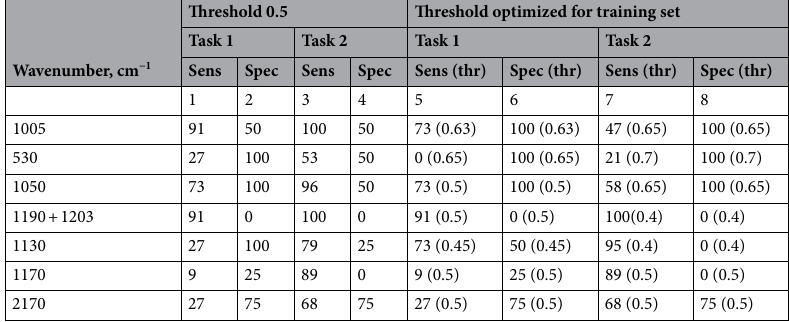
Table 2. Results of two-category blind analysis (healthy vs cancer). Task 1: 15H, 17PCa as training set and 4H, 11PCa as blind set. Task 2: 15H, 17PCa, 8BC + KC as training set, 4H, 11PCa, 8BC + KC as blind set. H: healthy, PCa, KC and BC: see the text. Sens sensitivity, Spec specificity, thr threshold for the second model applied to the training set, SD standard deviation. SRs at 1190 and 1203 were analyzed together.